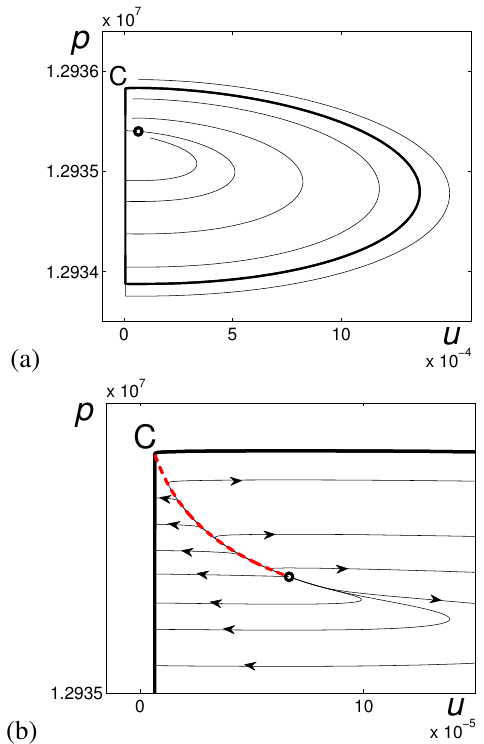
Figure 1. A scheme of the plug dynamics.